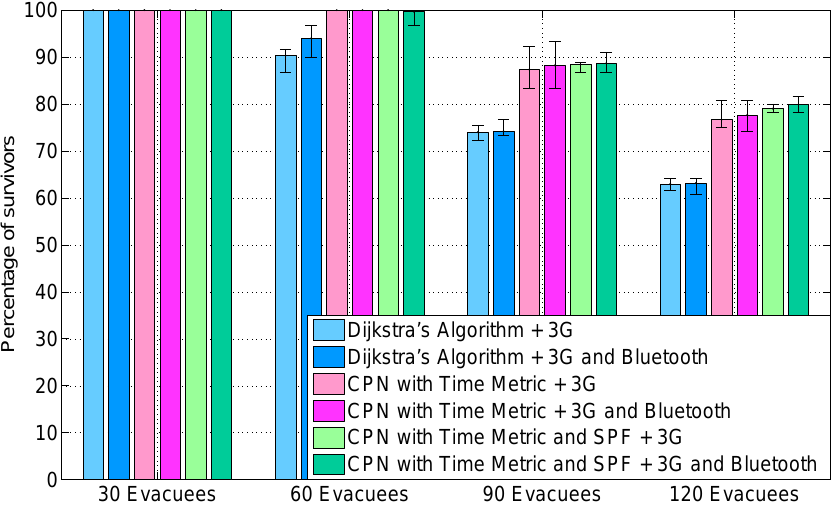
Figure 3. The percentage of survivors for each scenario. The results are the average of five randomized simulation runs, and error bars show the min/max result in any of the five simulation